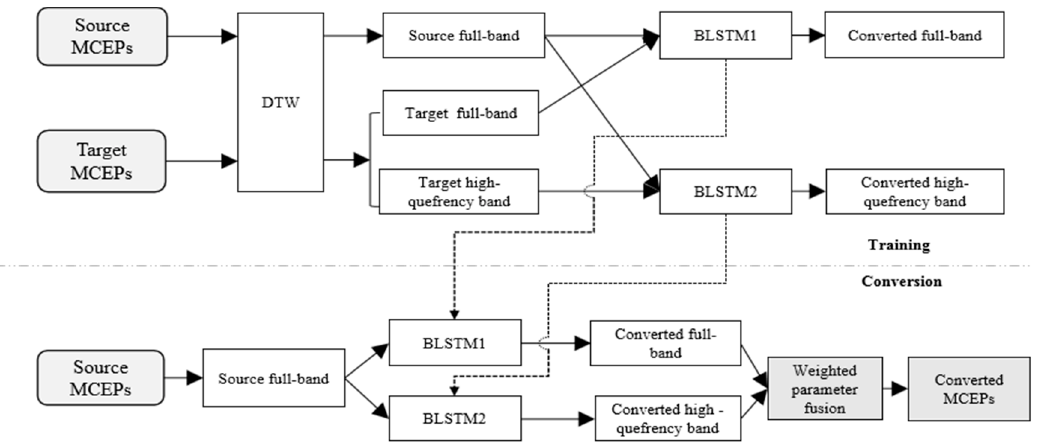
Figure 2. The flowchart of voice conversion with sub-band cepstrum conversion by BLSTMs. MCEPs: Mel-cepstral coefficients